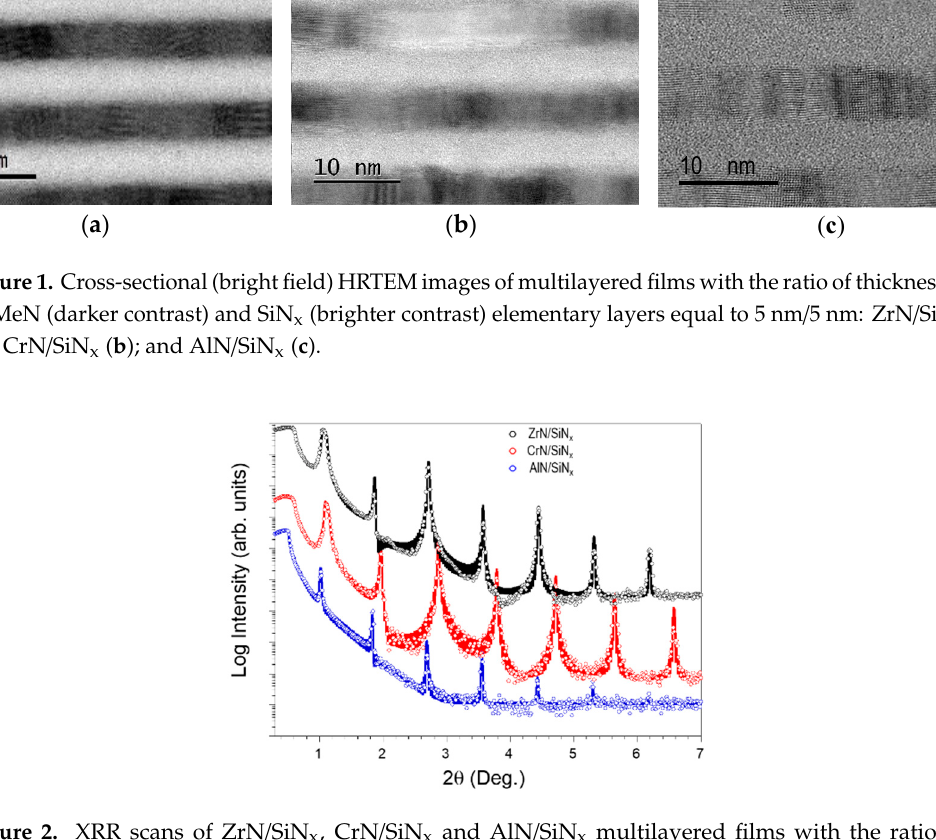
Figure 2. XRR scans of ZrN/SiN x , CrN/SiN x and AlN/SiN x multilayered films with the ratio of thicknesses of MeN and SiN x elementary layers equal to 5 nm/5 nm. Solid lines correspond to the best- fit simulations to experimental data using optical model of Parratt.